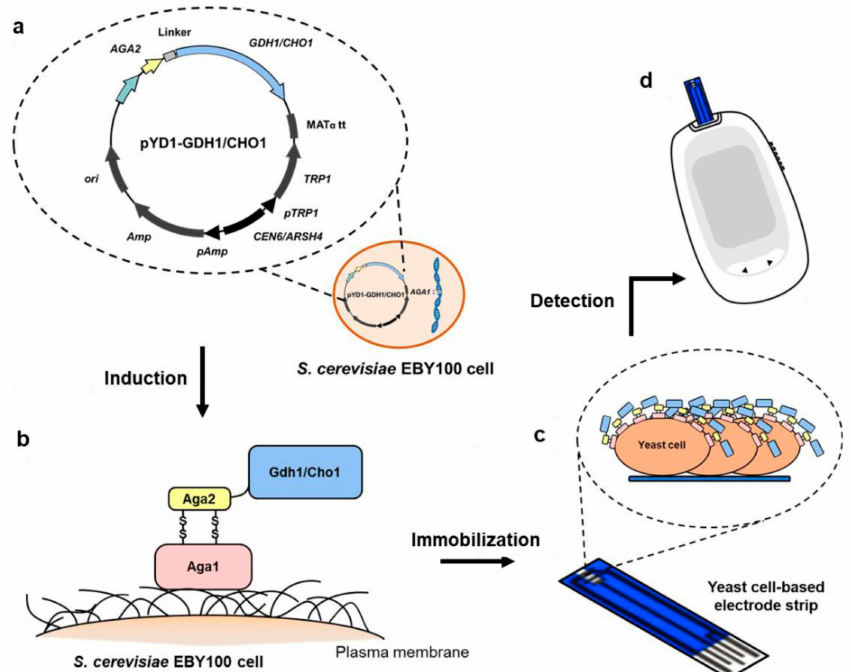
Figure 1. The strategy for constructing the surface-displayed glucose and cholesterol biosensors. ( a ) A map of the pYD1-GDH1 or pYD1-CHO1 vector. The enzyme Gdh1 or Cho1 (blue) was expressed as a C-terminal fusion to the Aga2 subunit of a-agglutinin (yellow) and connected by a linker (grey). ( b ) Displaying Gdh1 or Cho1 on the surface of yeast. The inducing Aga2 subunit associates with the a-agglutinin Aga1 subunit through two disulfide bonds. The Aga2-enzyme fusion protein was subsequently secreted to the extracellular space where Aga1 could be anchored to the cell wall through β -1, 6-glucan covalent linkage. ( c ) Fabrication of the whole-cell biosensors by immobilizing the YSD cells. ( d ) Electrochemical detection of glucose or cholesterol using a portable electrochemical